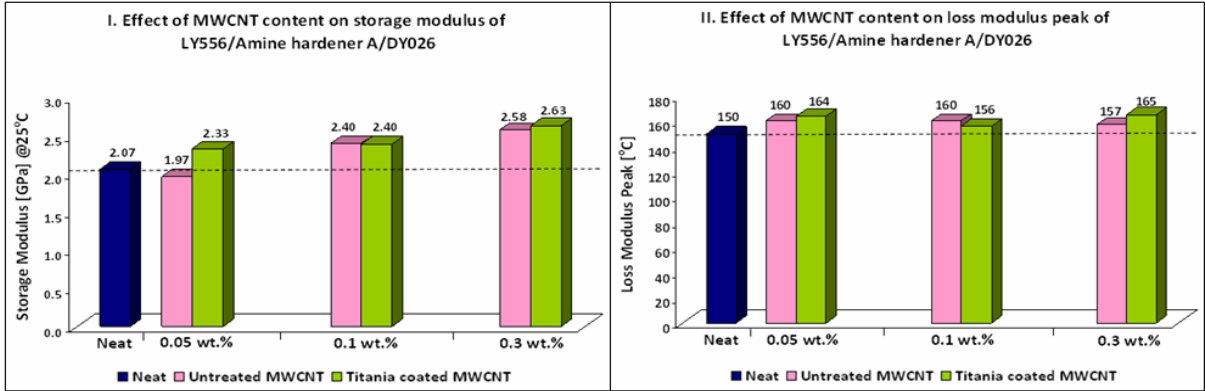
Figure 3. Effect of MWCNT content on thermo-mechanical properties of nanocomposites (Epoxy system